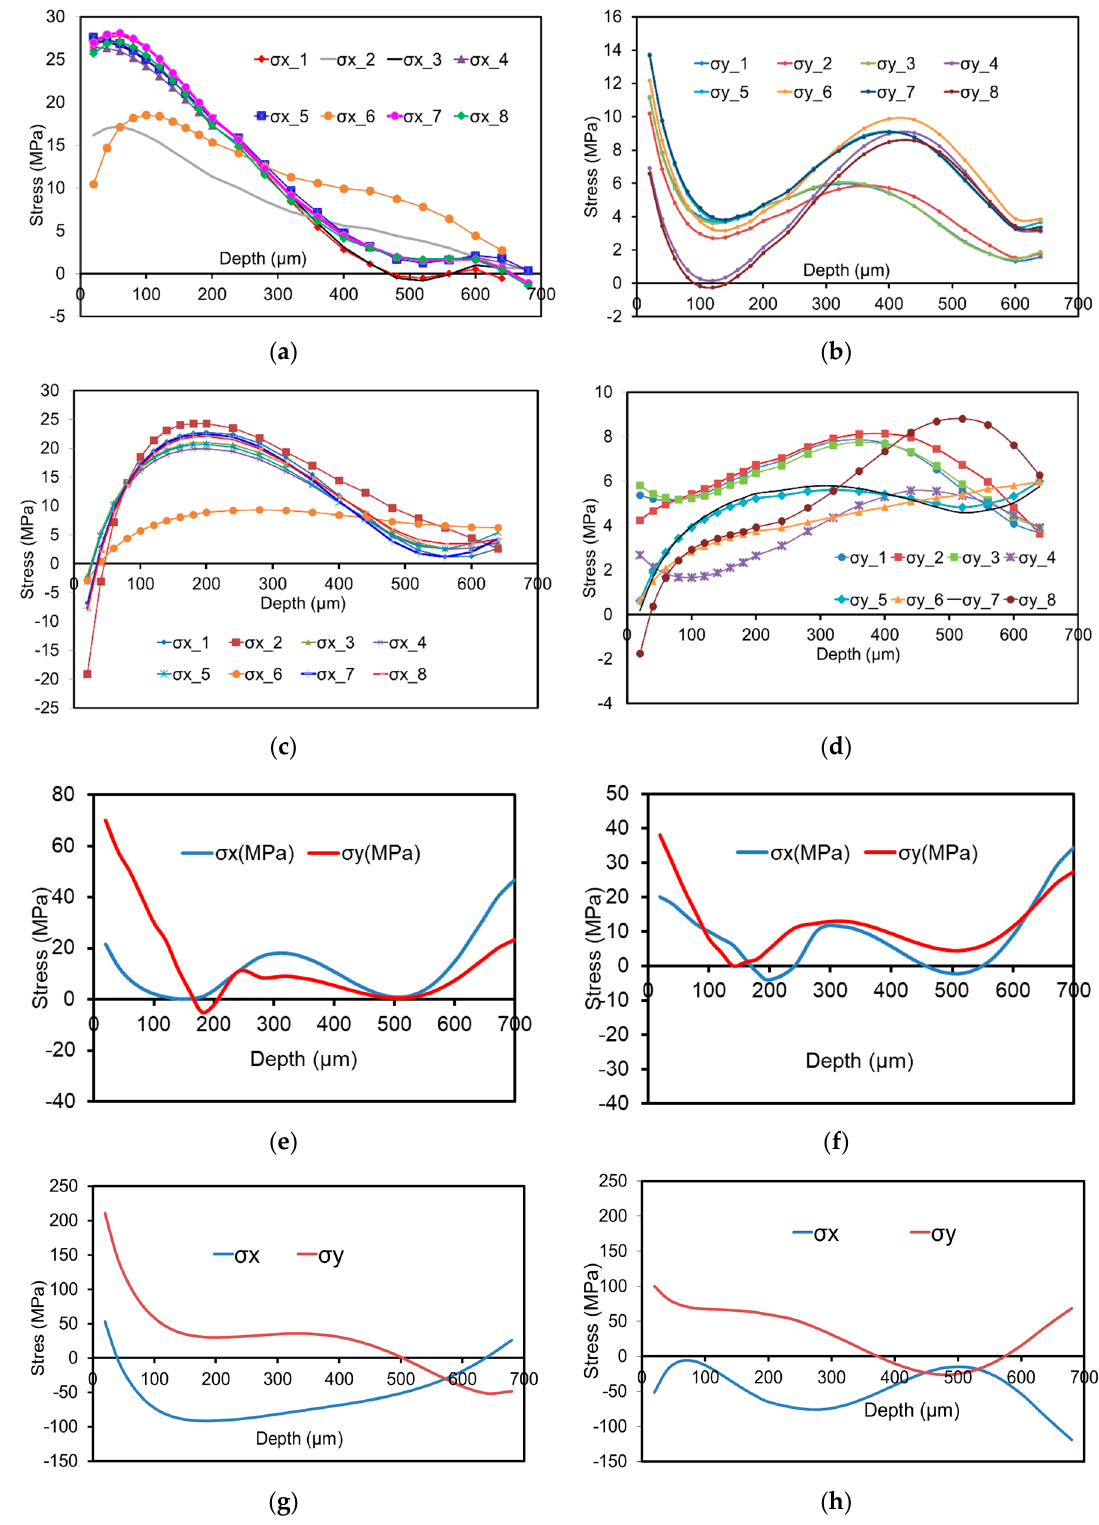
Figure 9. Experimentally determined stresses: ( a ) σ x at center point A on the CFRP side, ( b ) σ y at center point A on the CFRP side, ( c ) σ x at side point B on the CFRP side, ( d ) σ y at side point B on the CFRP side, ( e ) σ x and σ y at center point A on the metal side without hybridization, ( f ) σ x and σ y at side point B on the metal side without hybridization, ( g ) σ x and σ y at center point A on the metal side after hybridization, and ( h ) σ x and σ y at side point B on the metal side after hybridization. Numbers provided in ( a ) to ( d ) refer to the combination of strain gauges employed for calculation (cf. Figure 2).